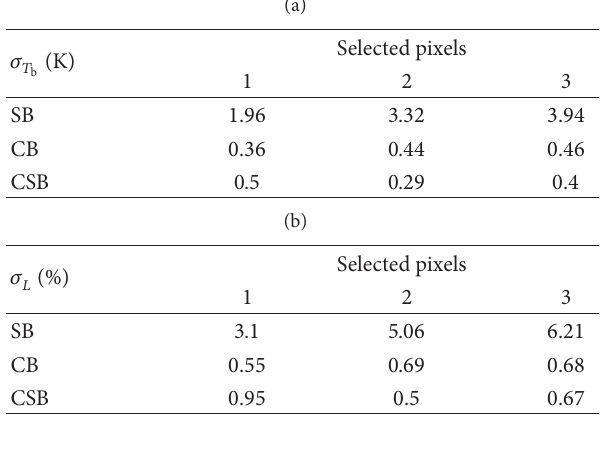
Table 2: Evaluation of the difference between expected background radiance and estimated background radiance, using one of the three methods used in this paper. The first table presents the root mean square of the brightness temperature error ( 𝜎 𝑇 summarizes the results in terms of the relative root mean square error on radiance ( 𝜎 𝐿 ).